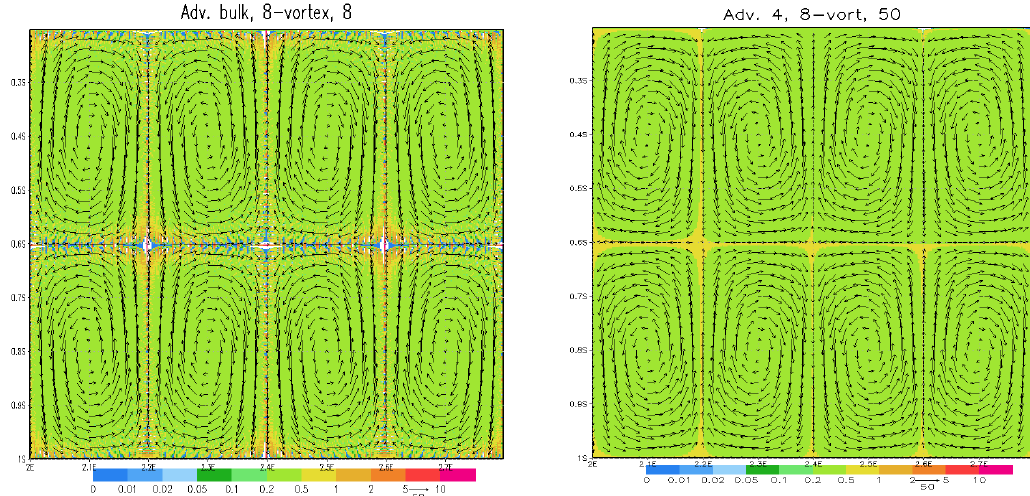
Figure 6. Test with eight non-divergent 2-D vortices. Left panel: test of the original scheme (5)–(7), time step 8; right panel: improved scheme (15)–(16), time step 50. Both tasks were initialised with constant value 0.4, also used as boundary conditions. Without